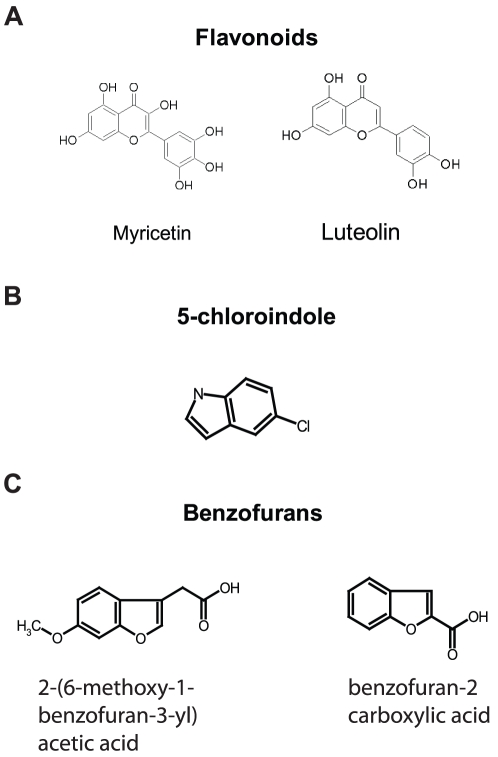
Chemical structures of the compounds identified as hits.(A) Structures of flavonoids luteolin and myricetin identified as EAG1 channel regulators by both electrophysiology and tryptophan fluorescence portions of the screen. (B) Structure of 5-chloroindole identified as EAG1 channel regulator by electrophysiology screen. (C) Structures of benzofurans 2-(6-methoxy-1-benzofuran-3-yl) acetic acid and benzofuran-2 carboxylic acid identified as binding partners of EAG1 channels by the tryptophan fluorescence portion of the screen.